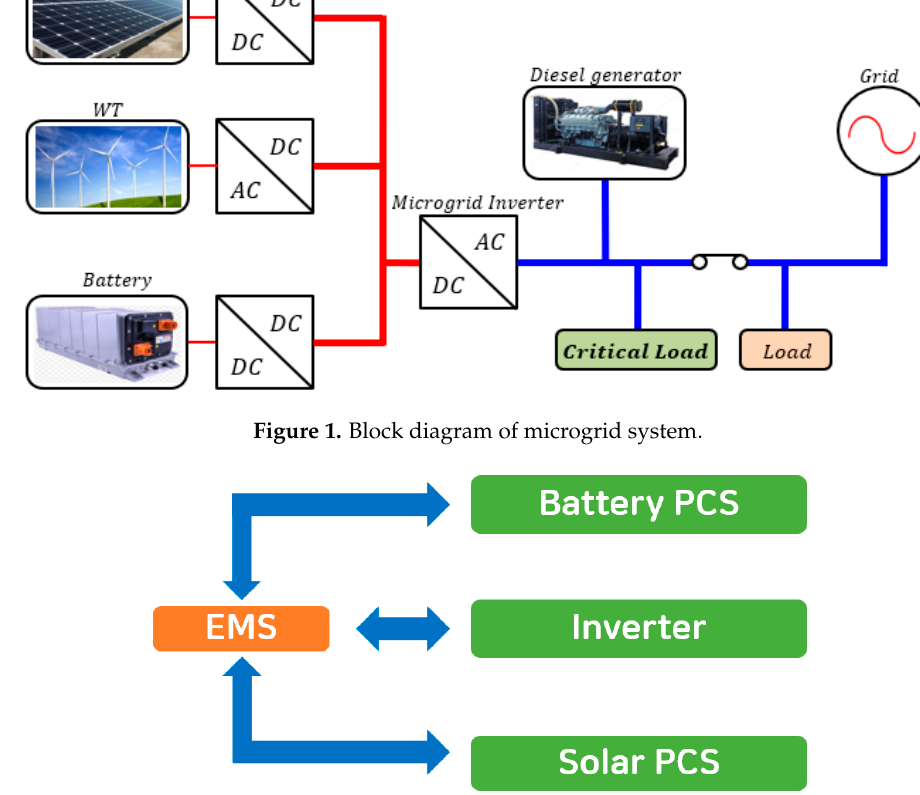
Figure 1. Block diagram of microgrid system.